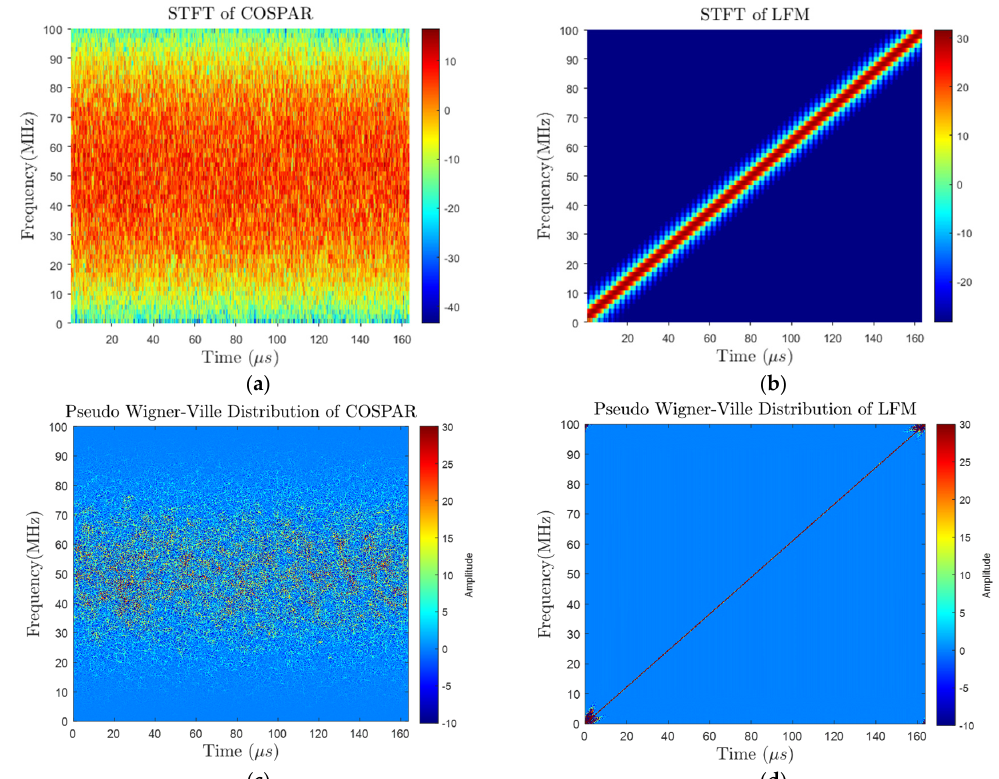
Figure 16. ( a ) STFT of COSPAR signal. ( b ) STFT of LFM signal. ( c ) Pseudo Wigner–Ville Distribution of COSPAR signal. ( d ) Pseudo Wigner–Ville Distribution of LFM signal.